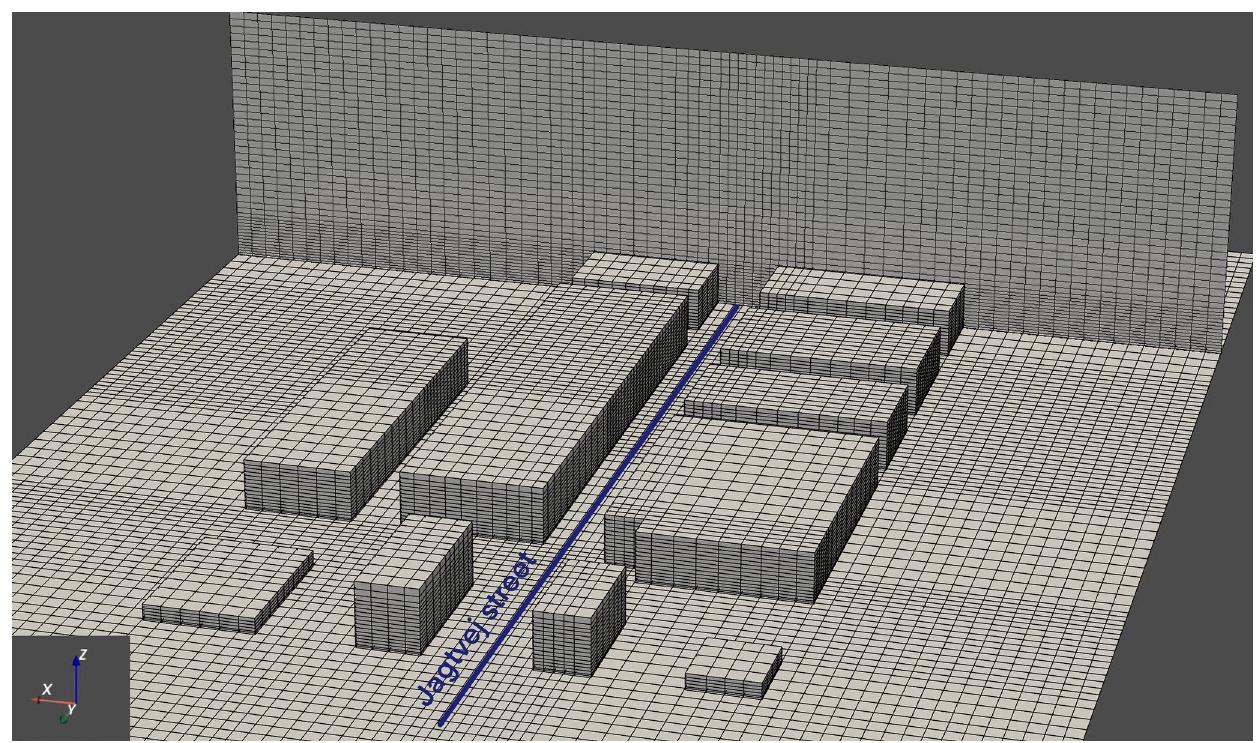
Figure A2. M2UE numerical grid of Jagtvej Street, Copenhagen,